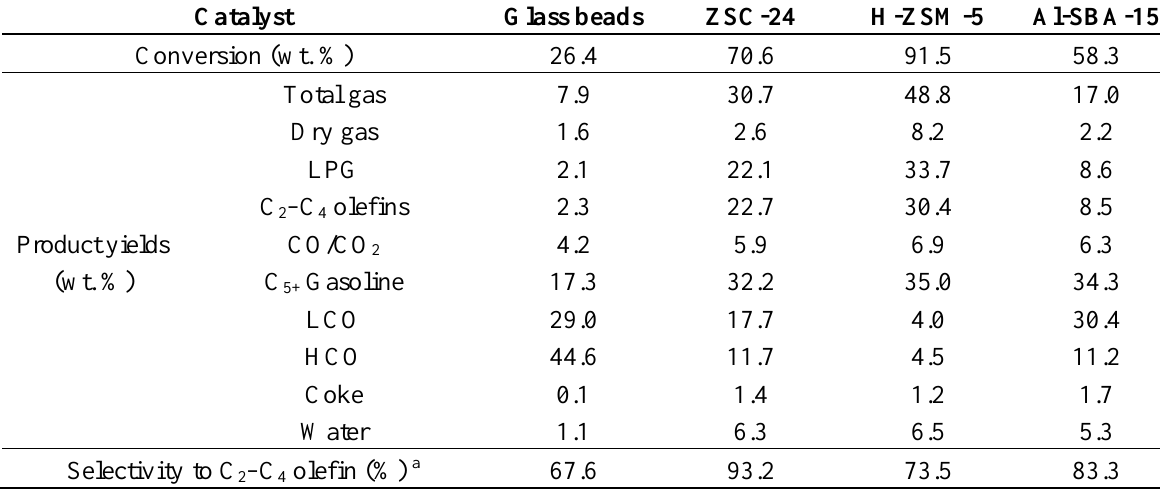
Table 4. Performance of ZSC-24 and the reference catalysts Al-SBA-15 and H-ZSM-5 in the cracking of WCO at 550 °C and a CTO ratio of 0.4 g·g −1